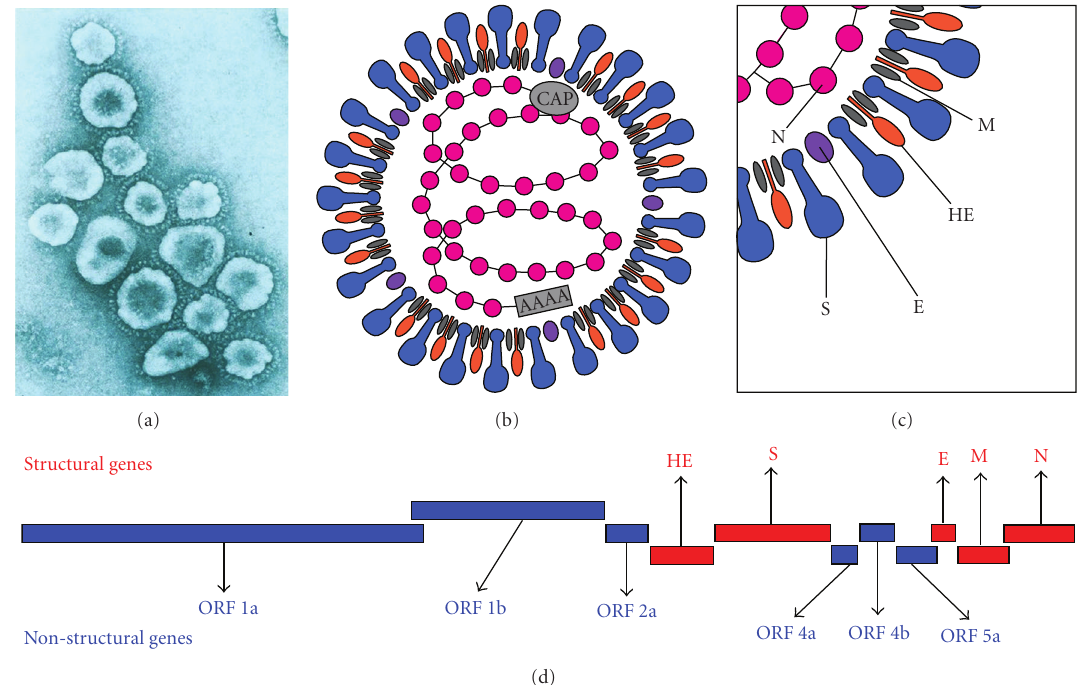
Figure 1: MHV virion and MHV genome: (a) electron micrographs of coronavirus particle. (b, c) Schematics of structural protein organization in the MHV virion; MHV virion is somewhat pleomorphic, containing an internal helical RNA genome-nucleocapsid phosphoprotein (N) complex, surrounded by an envelope containing glycoprotein peplomer (S, E, HE, and M) as specified in the text. (d) Organization of the genes in the MHV genome; structural genes are shown in red letters and nonstructural genes in blue